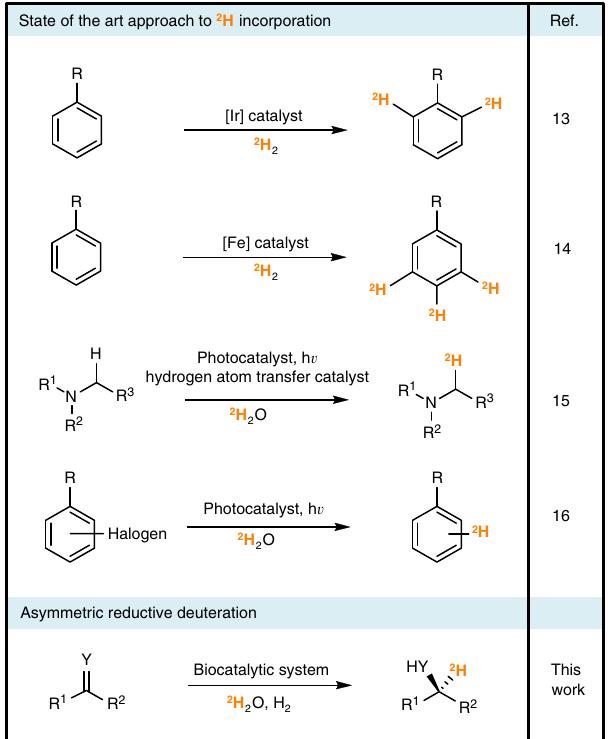
Fig. 1 Methods for introduction of deuterium into organic molecules and drug candidates. State-of-the-art approaches for carbon – hydrogen or carbon – halogen hydrogen isotope exchange; these methods use either 2 H 2 or 2 H 2 O as the deuterium source. The biocatalytic reductive deuteration strategy demonstrated in this work uses 2 H 2 O as the deuterium source and H 2 as a clean